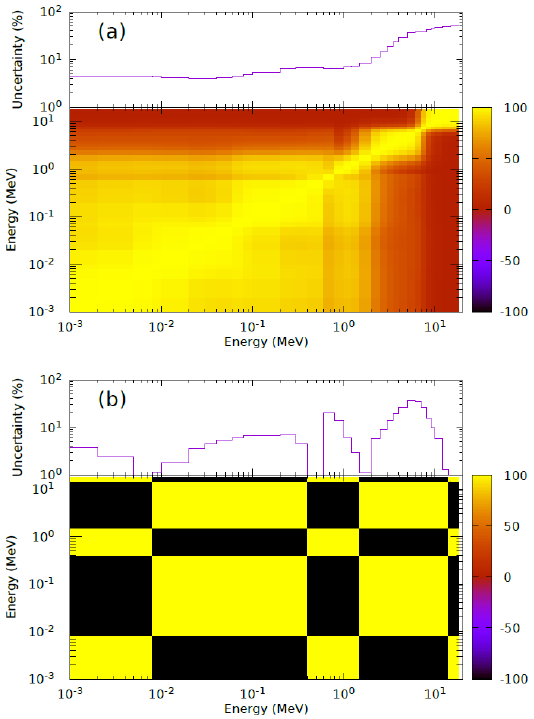
Fig. 5. Covariances of (a) KALMAN and (b) difference between posterior and original value for 237 Np capture cross section